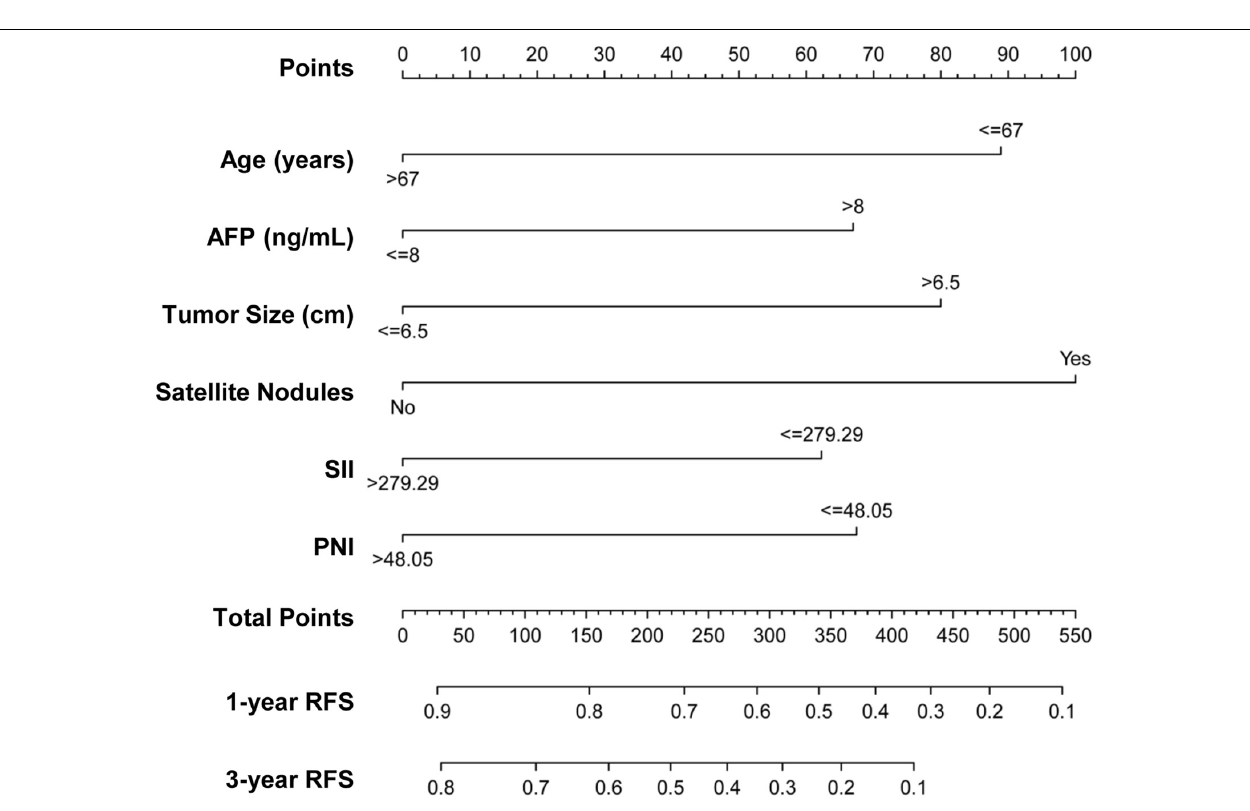
Frontiers in Oncology |